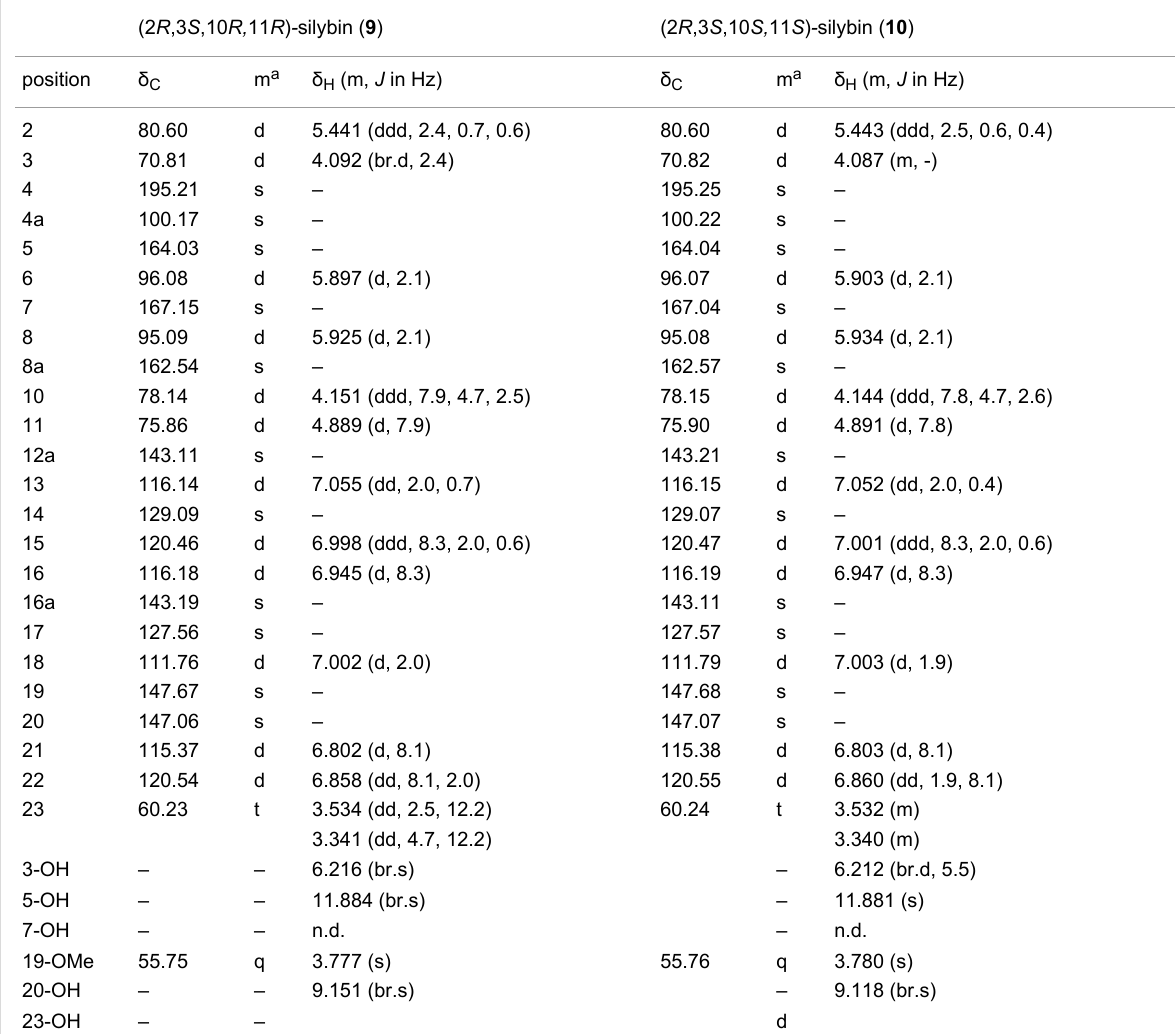
Table 6: NMR spectroscopic data (600 MHz, DMSO- d 6 , 30 °C) of compounds 9 and 10 . (2 R ,3 S ,10 R, 11 R ) - silybin ( 9